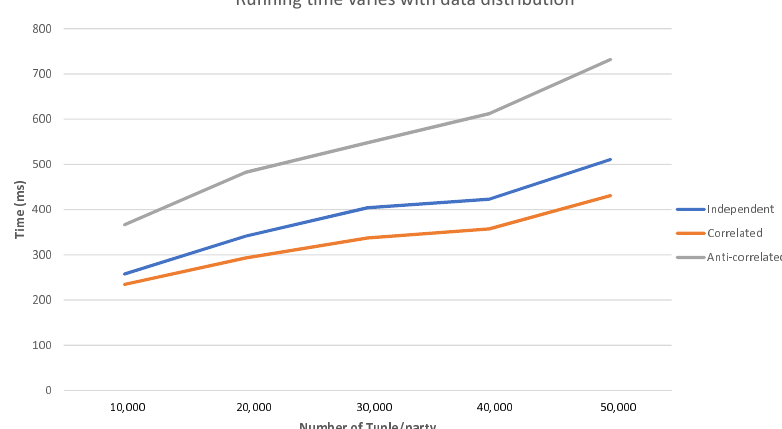
Figure 7. Running time varies with data distribution (attribute: 2, partitions: 30/attribute, value: